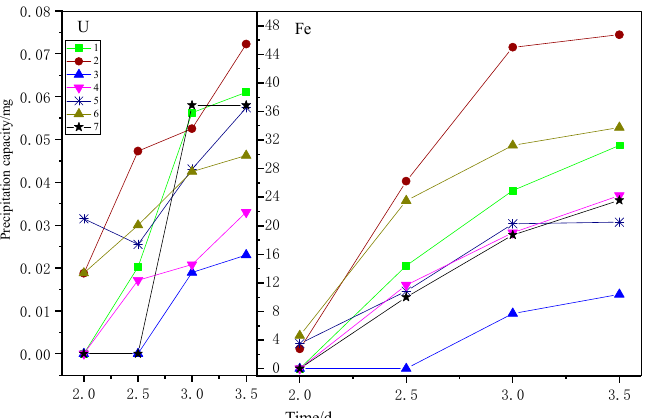
Figure 14. Corresponding relationship of U-Fe precipitation. [Line 1: P (O 2 ) = 1 MPa, c (Fe) = 2 g/L, c (U) = 90 mg/L. Line 2: P (O 2 ) = 1 MPa, c (Fe) = 3 g/L, c (U) = 90 mg/L. Line 3: P (O 2 ) = 1 MPa, c (Fe) = 1 g/L, c (U) = 50 mg/L. Line 4: P (O 2 ) = 1 MPa, c (Fe) = 2 g/L, c (U) = 50 mg/L. Line 5: c (H 2 O 2 ) = 1 g/L, c (Fe) = 2 g/L, c (U) = 50 mg/L. Line 6: c (H 2 O 2 ) = 2 g/L, c (Fe) = 2 g/L, c (U) = 50 mg/L. Line 7: P (O 2 ) = 0.5 MPa, c (Fe) = 2 g/L, c (U) = 90 mg/L].